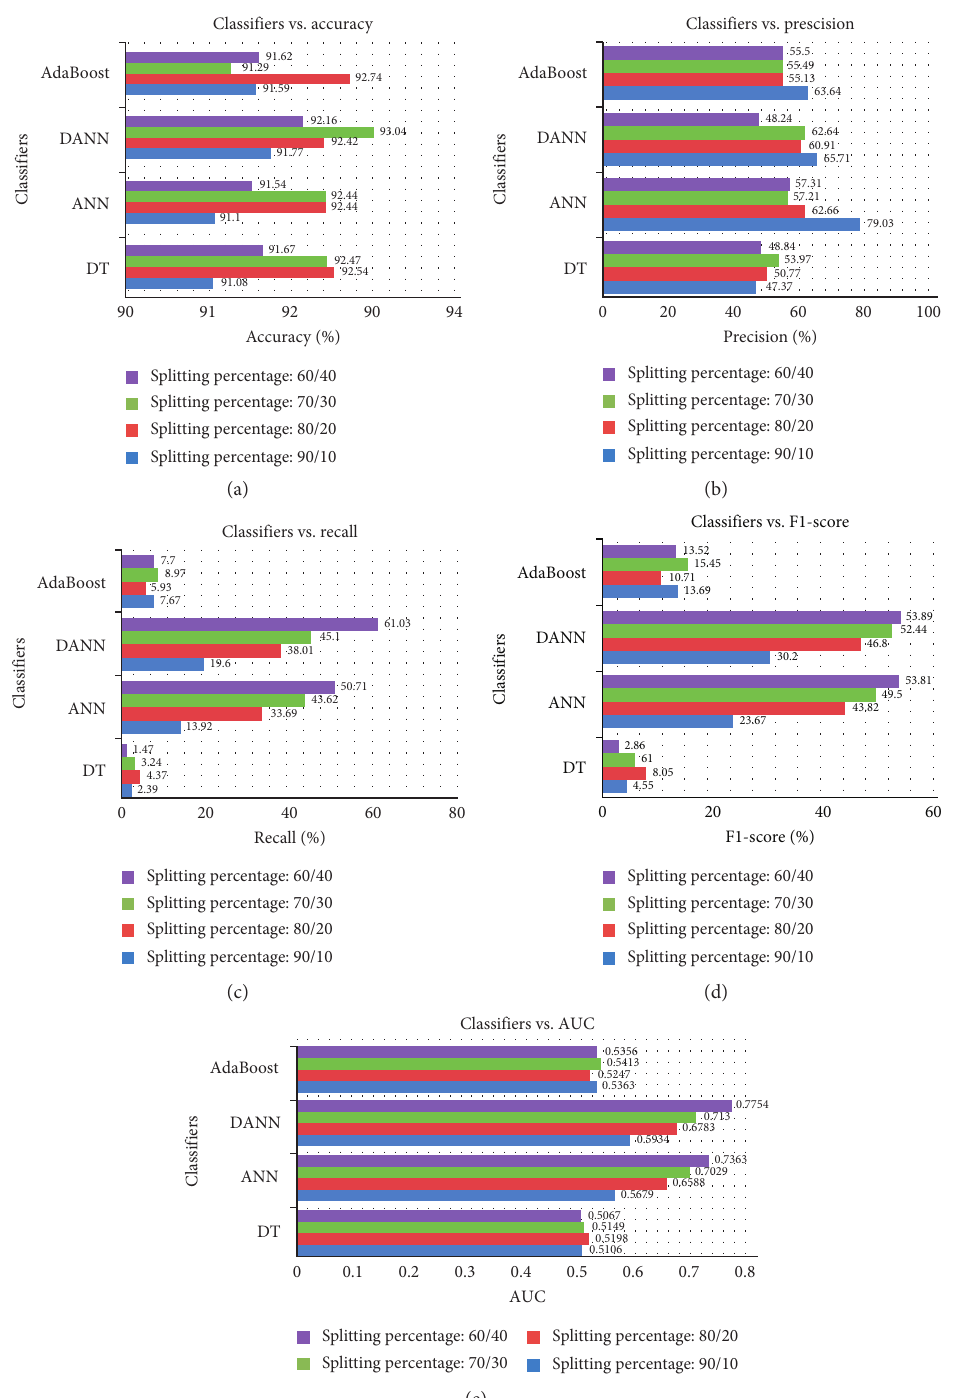
AdaBoost was almost consistent at about 55%. At the initial step of the precision test, DTseemed to be slightly increased at the 70/30 splitting percentage. However, its precision percentage slowly went downward at the 60/40 splitting percentage. The precision of DANN nearly achieved 66% when the splitting percentage was against 90/10.